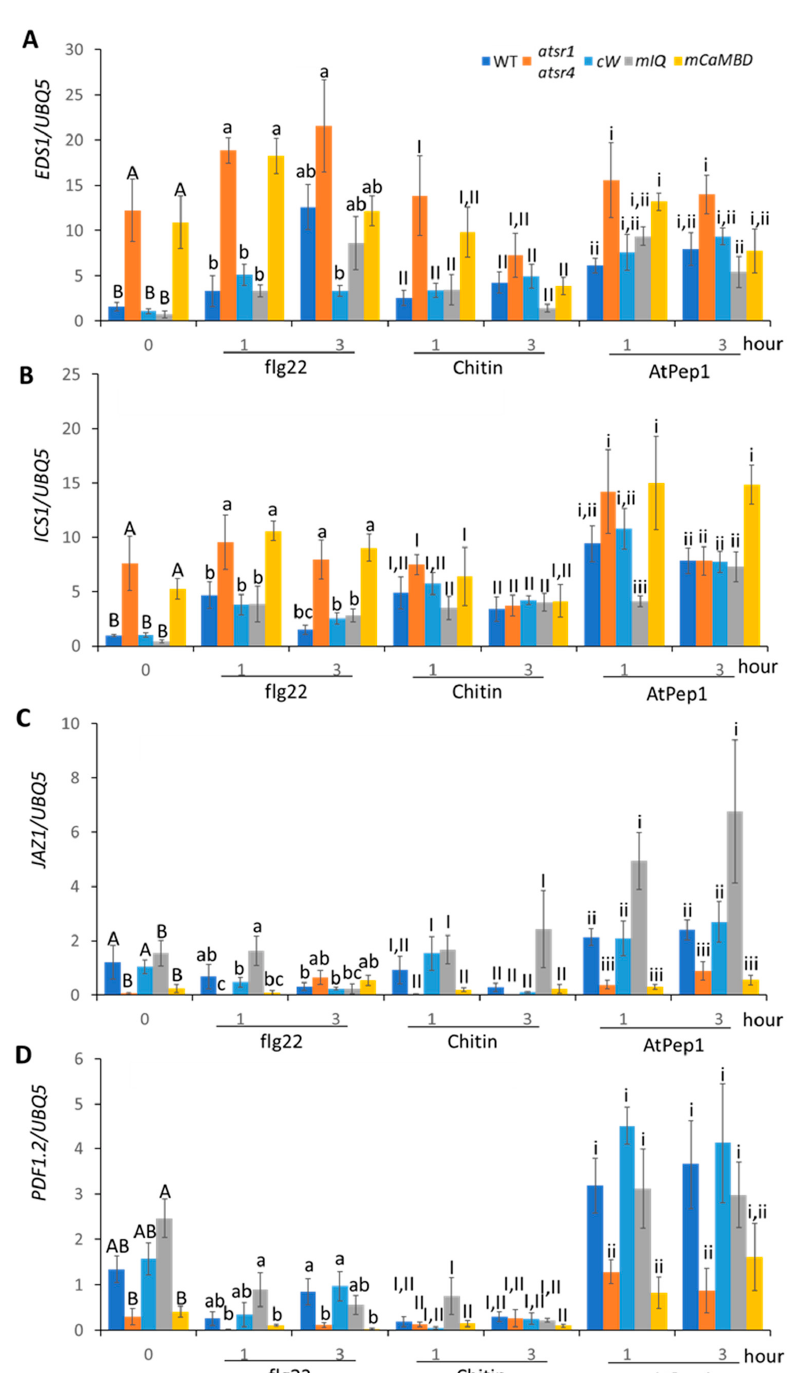
Figure 6. MAMP- and DAMP-induced transcriptional expression of SA- or JA-related genes in atsr1 and its complementation lines. Fold change in transcriptional expressions of ( A ) EDS1 , ( B ) ICS1 , ( C ) JAZ1 , and ( D ) PDF1.2 was shown in wild-type (WT), atsr1 atsr4 , and its complementation lines. Transgenes of complementation lines are intact AtSR1 gene ( cW ) and mutant AtSR1 gene defective either of IQ motif ( AtSR1 A855V = mIQ ) or CaMBD ( AtSR1 K907E = mCaMBD ). The Arabidopsis leaves were treated with 1 µ M of flg22, chitin, and AtPep1 for 1 or 3 h. The gene expression was normalized to that of the UBQ5 gene. Values were means ± SD of three biological replicates. Di ff erent letters indicated statistically significant di ff erences among treatments analyzed by one-way ANOVA ( p < 0.05) with Tukey